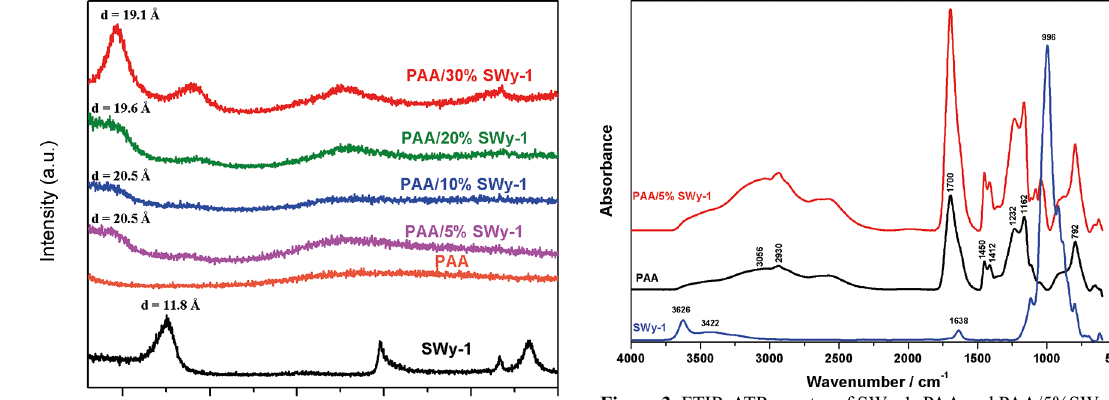
Figure 3. FTIR-ATR spectra of SWy-1, PAA and PAA/5%SWy-1 nanocomposite film. the surface of the film. The amount of SWy-1 particles on the surface of the PAA/30%SWy-1 is more than PAA/10%SWy-1 nanocomposite film. In addition, the image of cross section (Figure 4c) shows the thickness of the films was 65 to 70